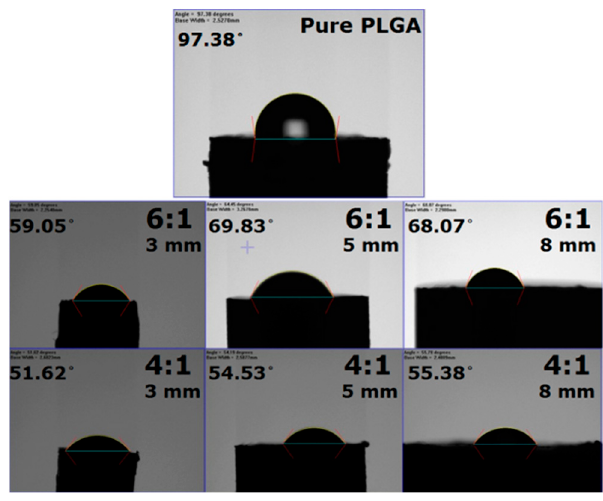
Figure 5. Water contact angles for pure Poly( D , L -lactide- co -glycolide) and drug-loaded beads of different polymer:drug ratios and sizes.